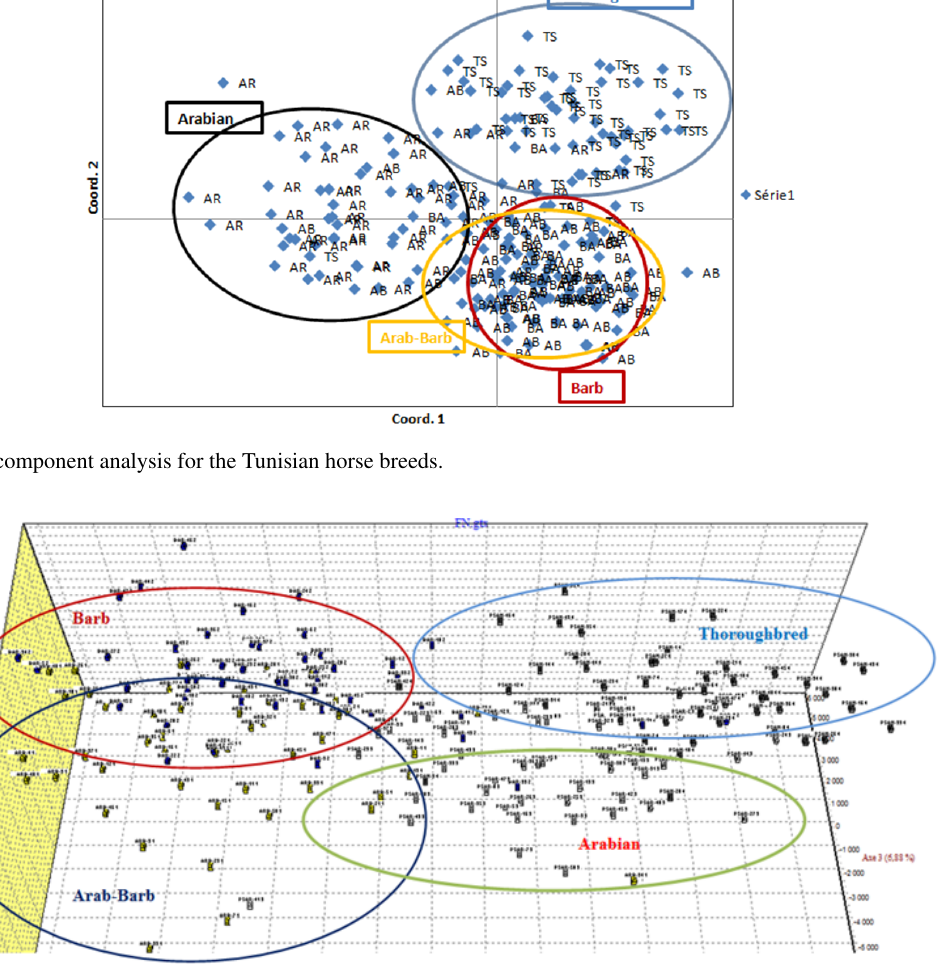
Figure 3. Factorial correspondence analysis for the Tunisian horse breeds.